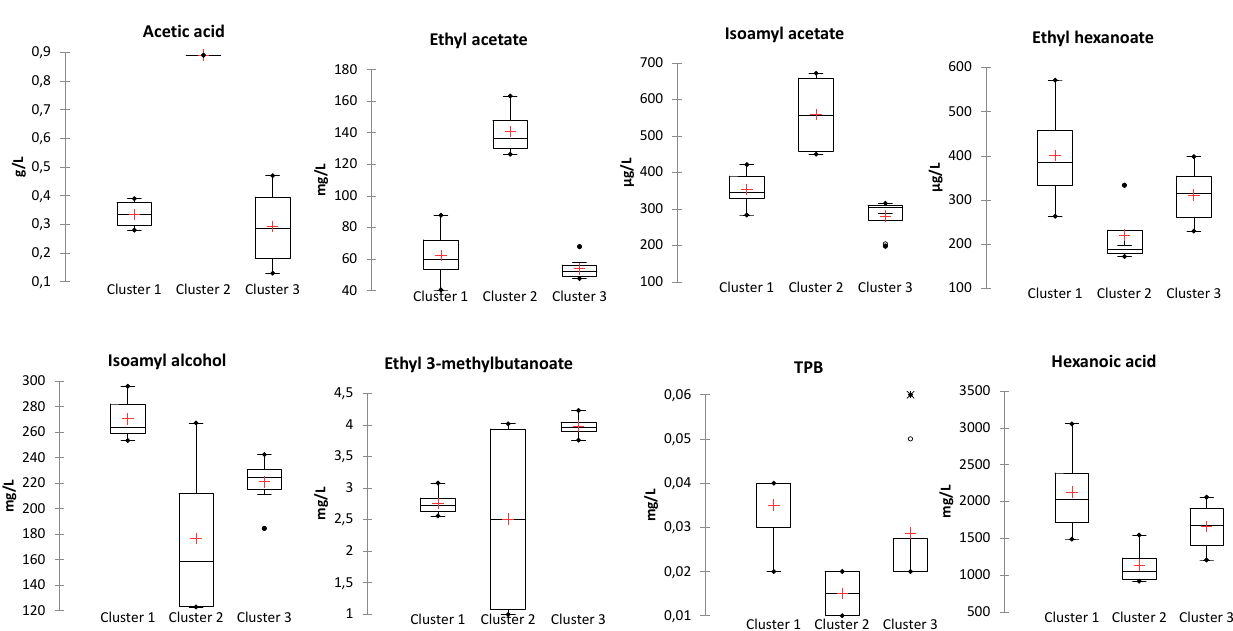
Figure 5. Box plots of significantly different compounds (Kruskal–Wallis, α = 0.05) between sensory clusters of Corvina wines.